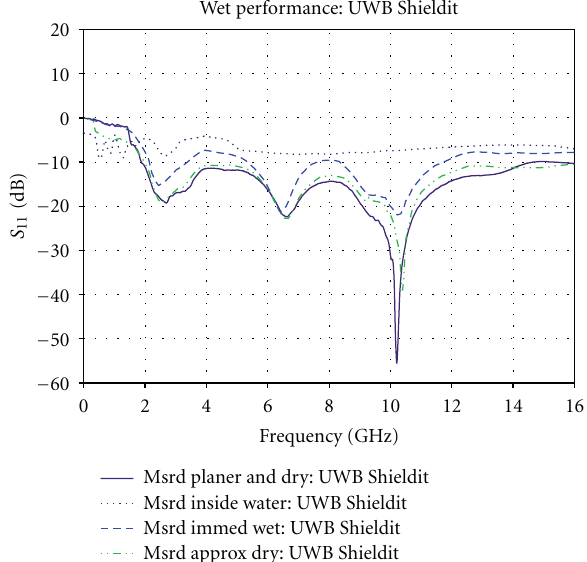
Figure 15: Measured ( | S 11 | ) results of UWB antenna prototype using Shieldit conducting fabric considering several wet